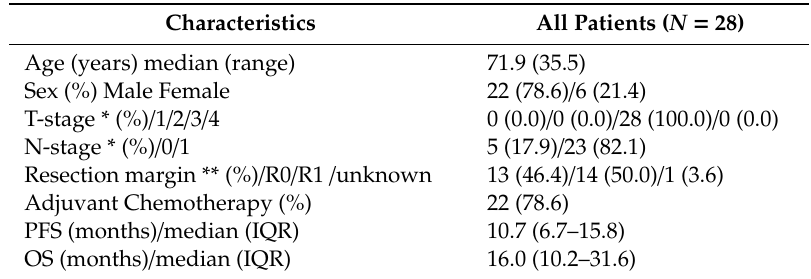
Table 1. Patient characteristics. Patients who underwent pancreaticoduodenectomy for pancreatic cancer and were included for serum miR analysis.